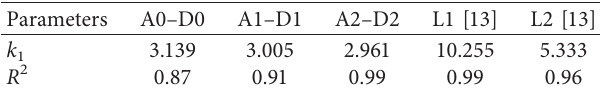
Figure 3: Effect of water pressure on the reduction rate of strength. Table 5: Fitting parameters of the relationship between reduction rate of strength and water pressure.